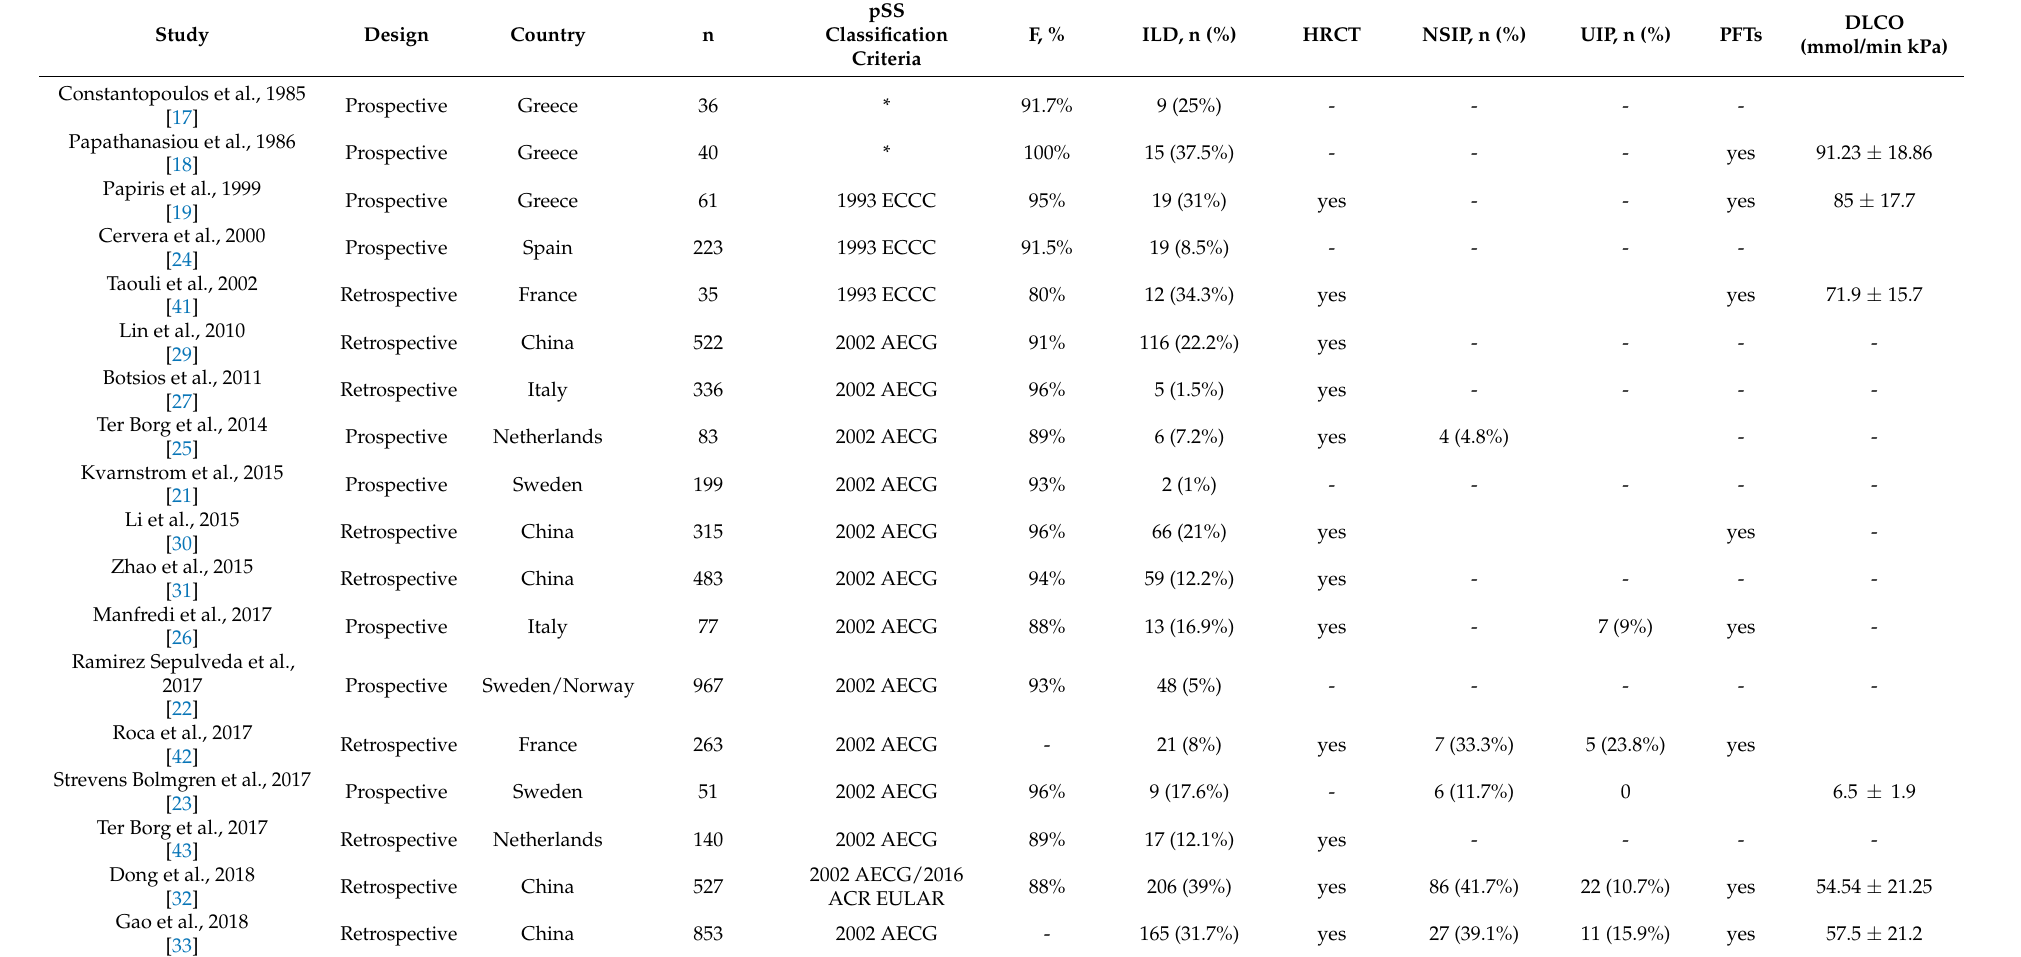
Table 1. Main characteristics of included